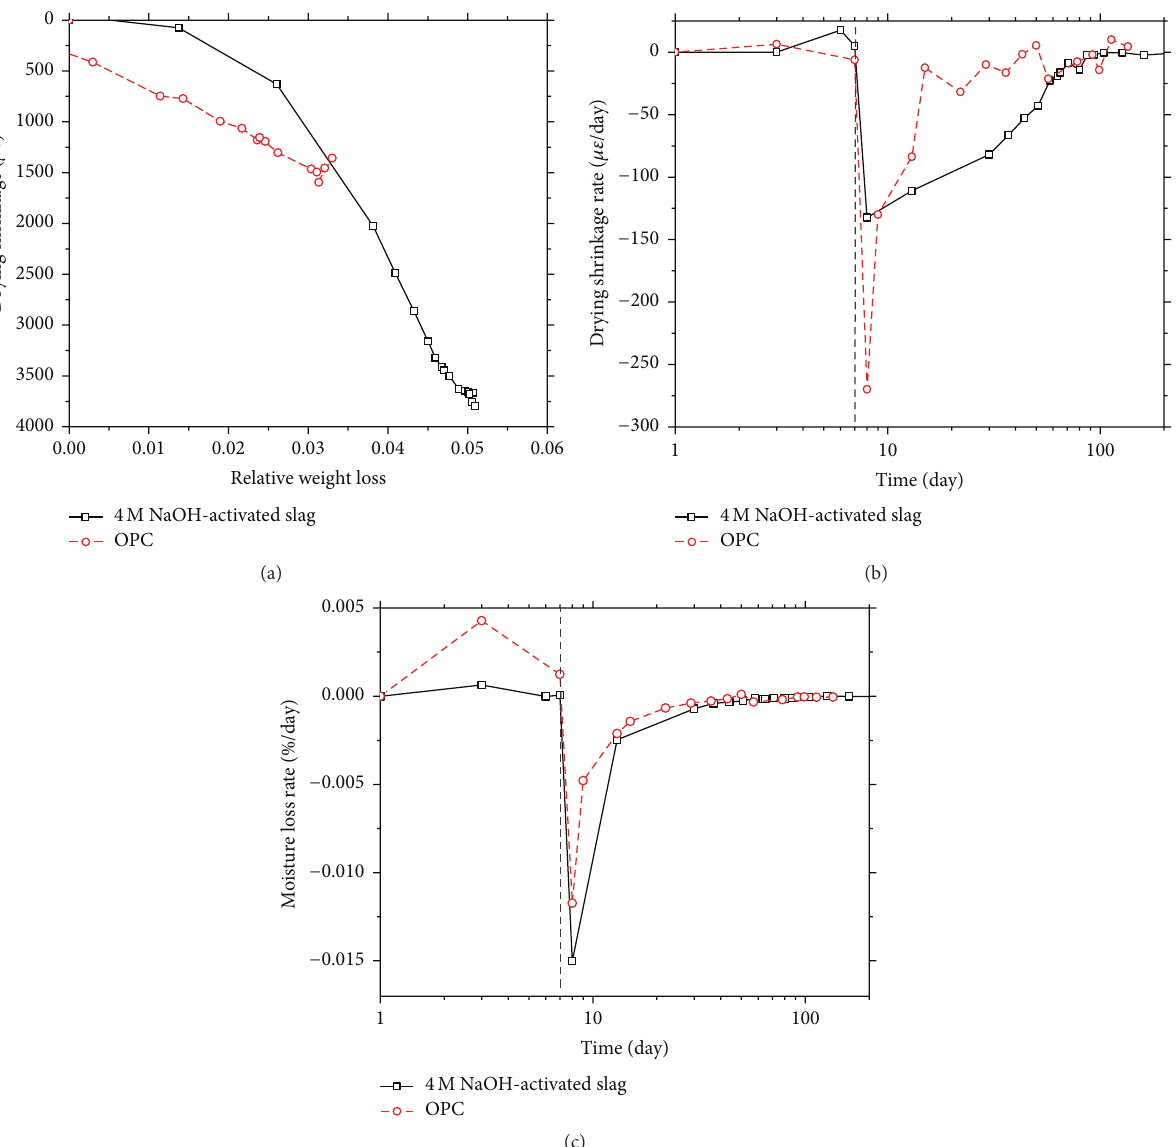
Figure 1: (a) The correlation between drying shrinkage strain and relative weight loss present in AAS and OPC systems; (b) the time- dependent change of drying shrinkage rate in AAS and OPC systems; (c) the time-dependent change of moisture loss rate based on data from author’s previous publication [14]; the dashed lines in (b) and (c) indicate the time when drying was initiated, that is, 7